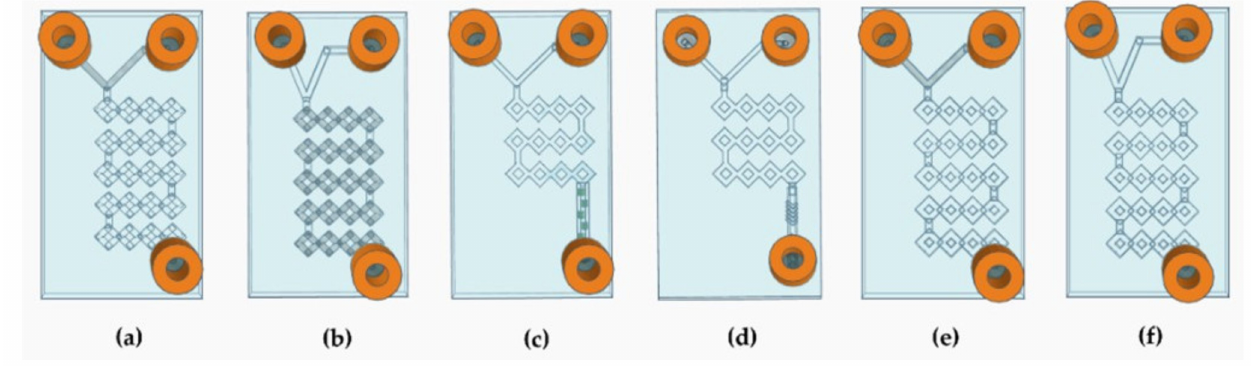
Figure 3. Schematic representation of the devices’ CAD design. ( a ) Representation of device 1. ( b ) Representation of device 2. ( c ) Representation of device 3. ( d ) Representation of device 4. ( e ) Representation of device 5. ( f ) Representation of device